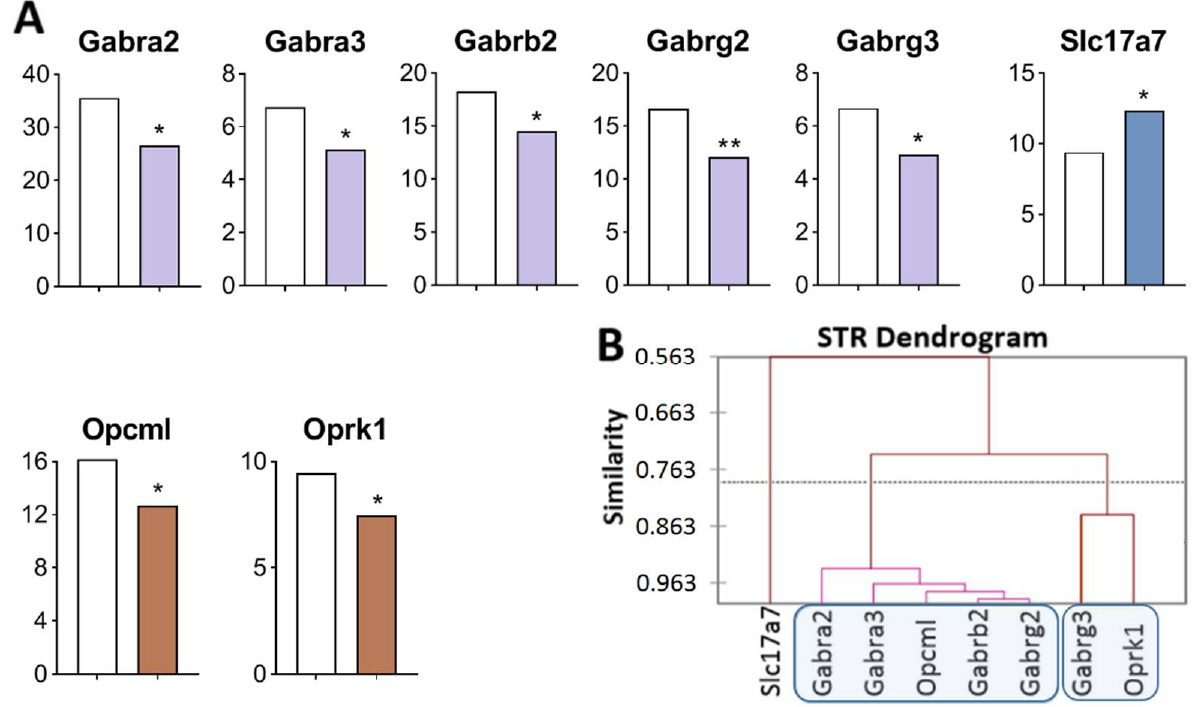
Figure 3. DEGs in the STR of highly aggressive mice. ( A ) FPKM of opioidergic, GABAergic, and glutamatergic DEGs in the STR. White bars—controls; colored bars—winners: brown—opioidergic genes; lilac—GABAergic genes; violet—glutamatergic genes. * p < 0.05; ** p < 0.01 (Supplementary Table S1). ( B ) AHC based on expression profiles of eight reference DEGs (Supplementary Table S2). Similarity: Pearson’s correlation coefficient. Agglomeration method: Unweighted pair-group aver- age. The main clusters are highlighted with a blue rounded rectangle.